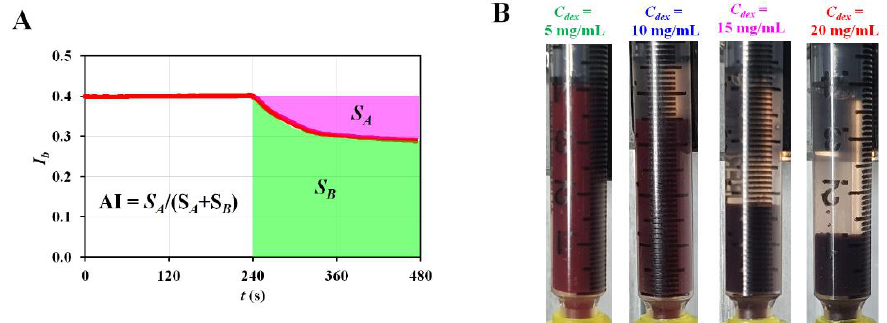
Figure A1. Quantification of RBC aggregation with aggregation index (AI). ( A ) Formula of AI by analysing temporal variations in I b . The AI was defined as AI = S A /(S A + S B ). ( B ) Snapshots showing RBC sedimentation in the driving syringe captured at the end of experiments ( t = 1680 s) with respect to C dex .